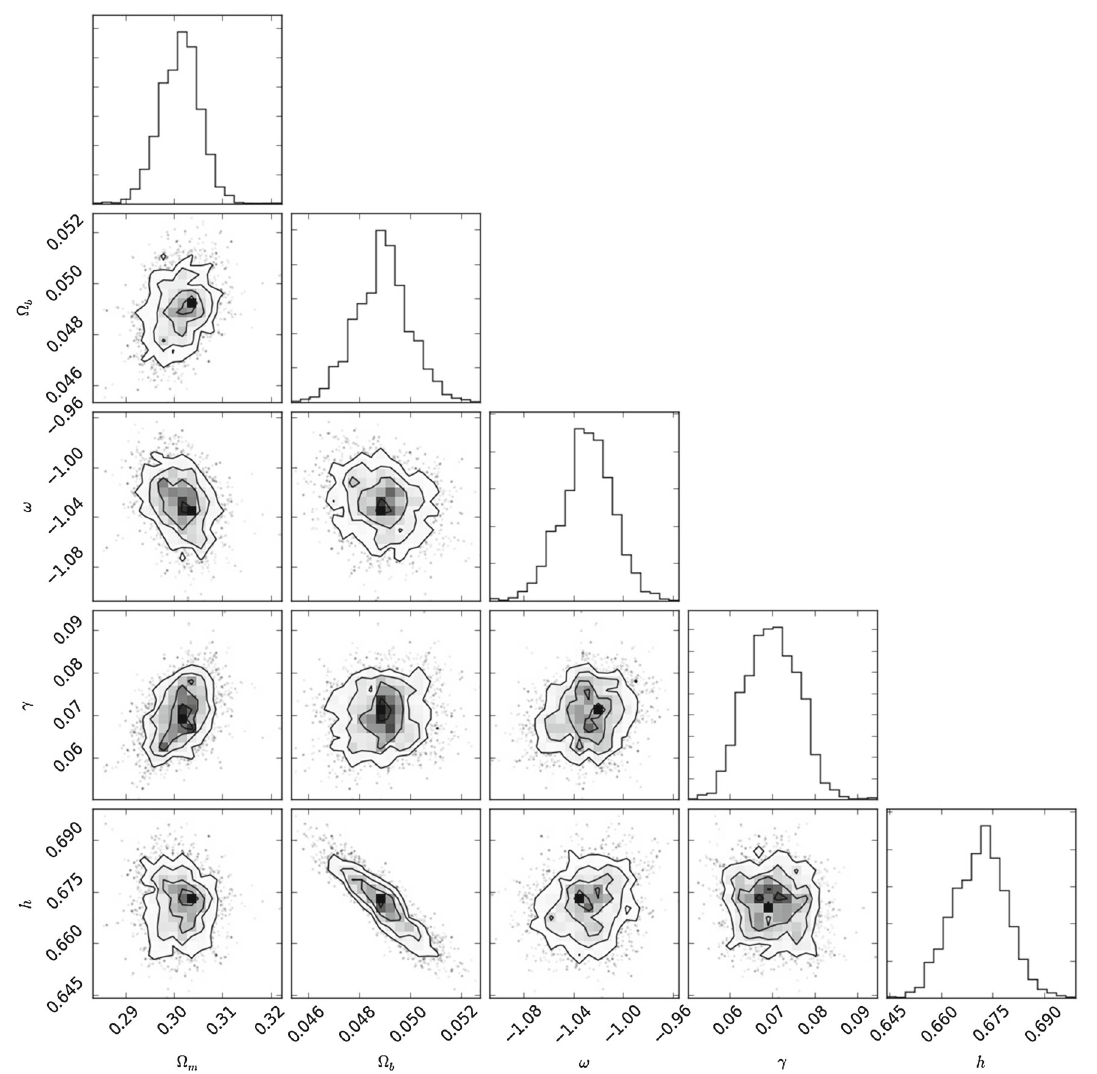
Fig. 4 We display confidence boundaries for 1 σ , 2 σ and 3 σ for the model (ii) for the free parameters ((cid:8) m ,(cid:8) b ,ω,γ, h ) using all the